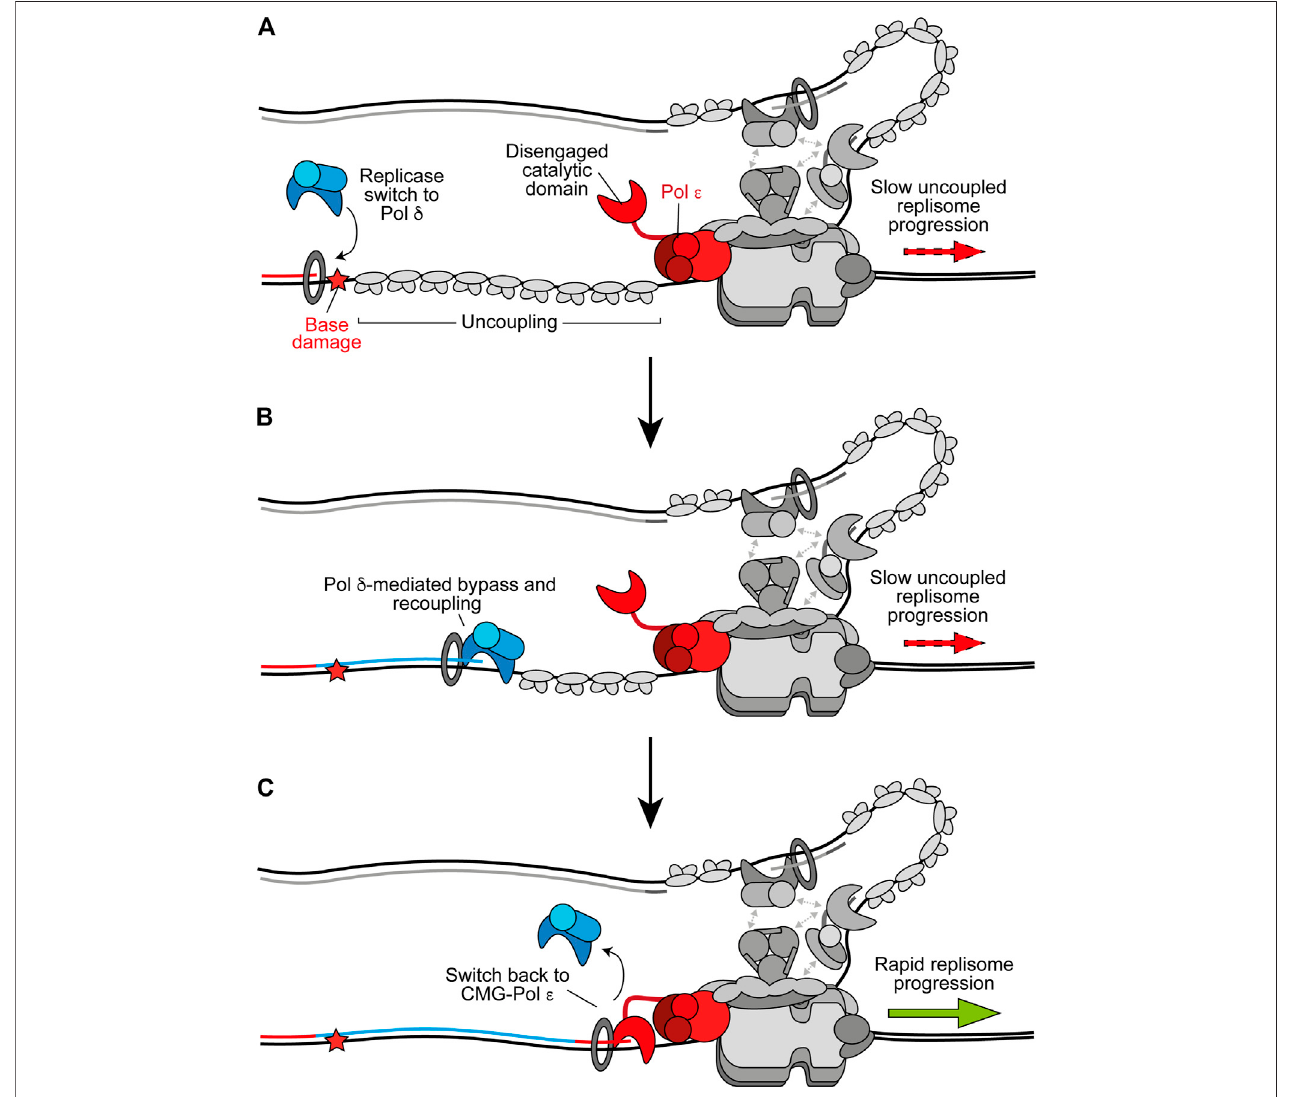
FIGURE 3 | Replicase switching and recoupling of leading-strand synthesis. (A) Upon uncoupling, a replicase switch occurs. Here, Pol δ is recruited to the uncoupled nascent leading strand. Other replisome components are shown in gray for clarity. (B) When stalling of Pol ε occurs due to any factor that is more readily toleratedbyPol δ ,suchascertainoxidativelesions,Pol δ directlyextendsthenascentleadingstrandthroughtheimpedimenttorecouplesynthesis. (C) Uponrecoupling the nascent leading strand is handed back to CMG-bound Pol ε to restore rapid replisome progression. Synthesis by Pol ε and Pol δ is shown in red and blue